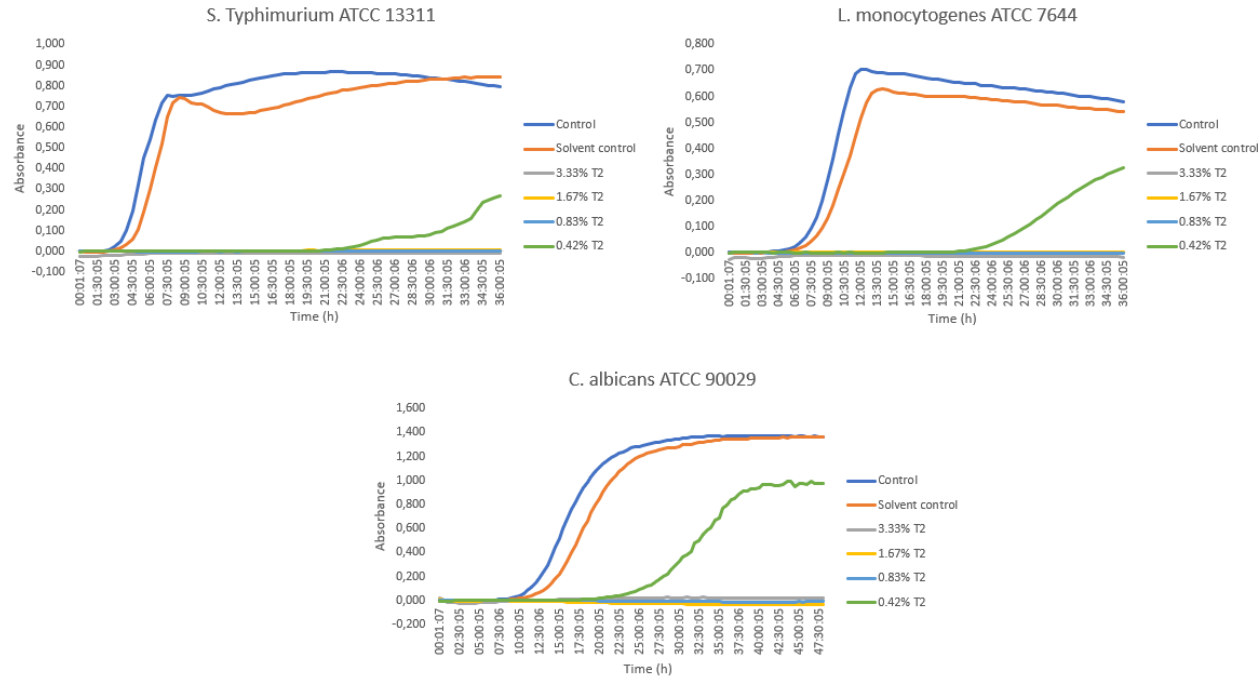
Figure 2. Growth curves of Salmonella , Listeria and Candida strains for the sample T2 in solution concentrations of 3.33% ( v / v ) (grey line), 1.67% ( v / v ) (yellow line), 0.83% ( v / v ) (light blue line) and 0.42% ( v / v ) (green line) in Bioscreen C assays. (Control (blue line) = microbe control, Solvent control (red line) = 2.9% DMSO).